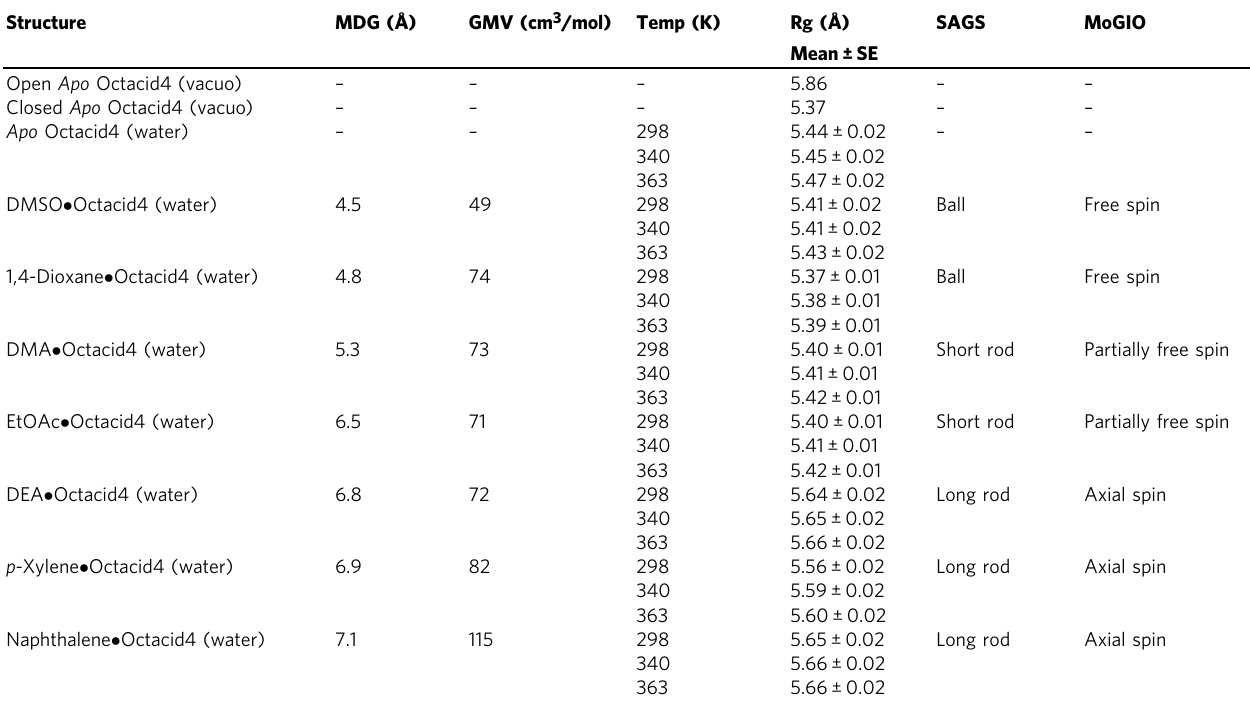
Table 1 Static and dynamic properties of Octacid4 and its complexes.